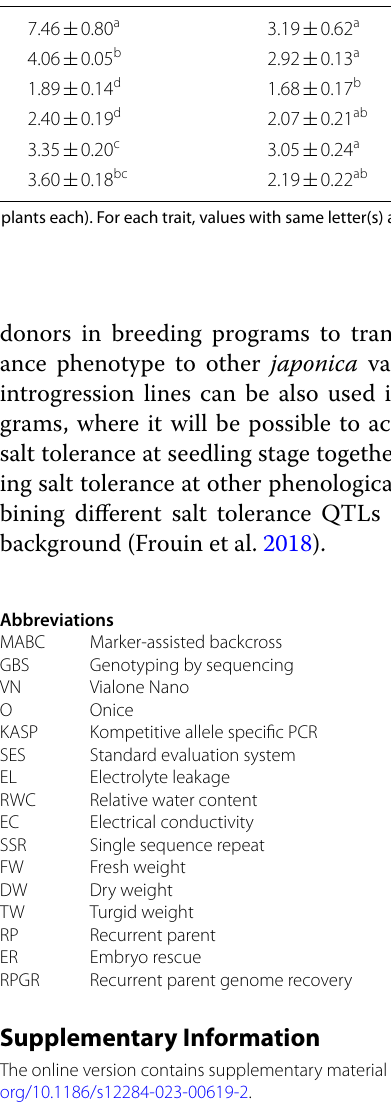
Table 5 Na + /K + molar ratios in different tissues of VN1, VN4, O1 introgression lines and parental IR64- Saltol , the tolerant check, Vialone Nano (VN) and Onice (O), the susceptible checks